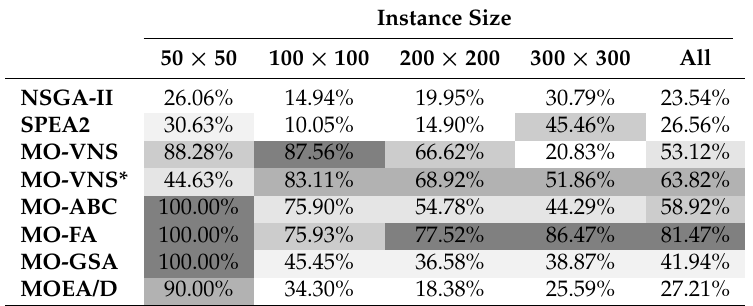
Table 5. Average set coverage for a metaheuristic compared to any other solving the bi-objective RNPP. Instance